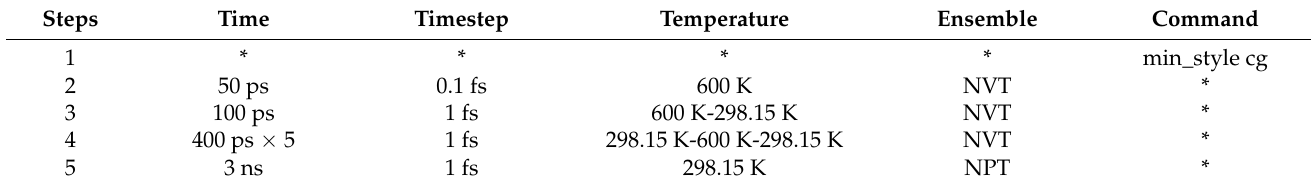
Figure 3. Molecular model of asphalt binder (red: asphaltene, blue: saturated, green: aromatic, yel- low: resin).